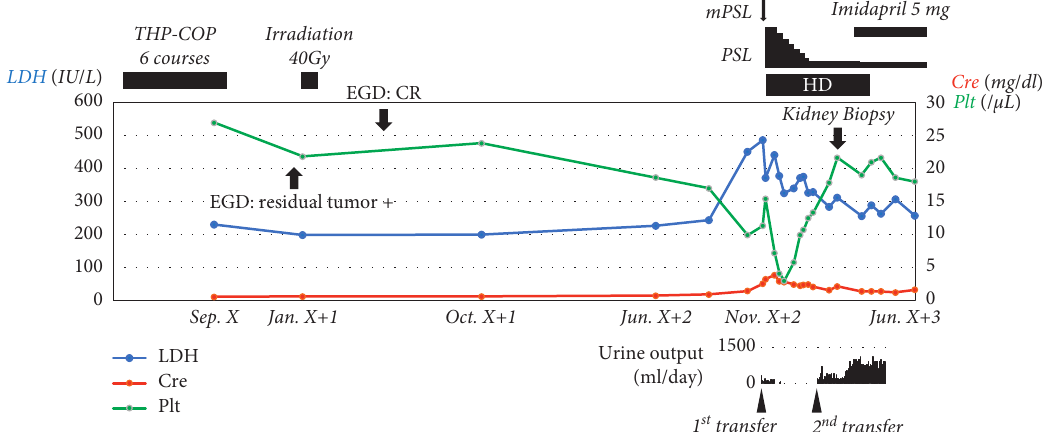
Figure 1: Clinical course of the patient. THP-COP: combination of pirarubicin, cyclophosphamide, vincristine, and prednisolone, EGD: esophagogastroduodenoscopy, CR: complete response, mPSL: methyl prednisolone pulse therapy, PSL: prednisolone, HD: hemodialysis, LDH: lactate dehydrogenase, Cre: creatinine, and Plt: